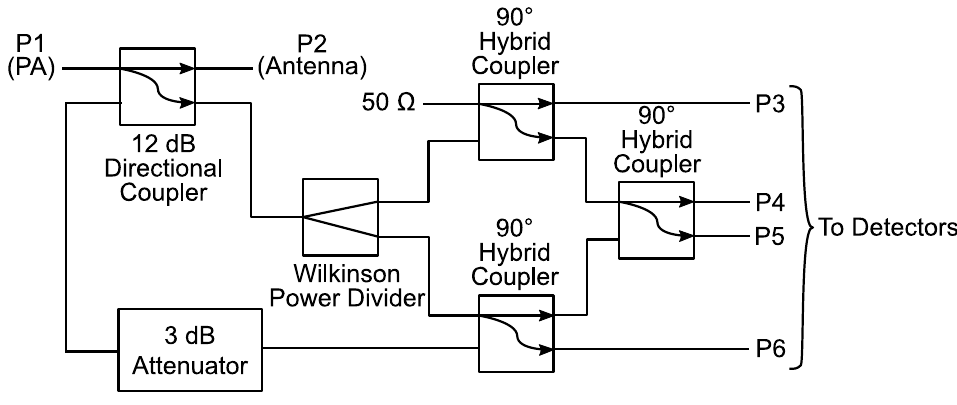
Figure 3. Structure of the six-port junction.